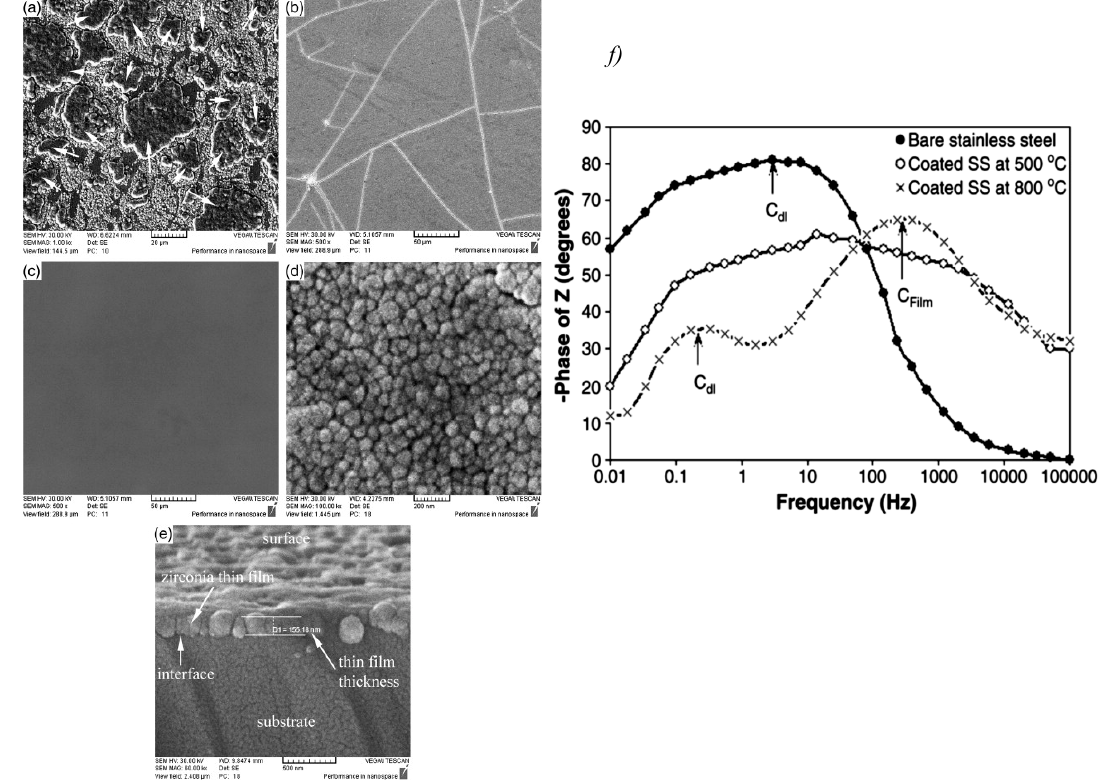
Figure 16. ( a – e ) SE ‐ SEM images of: ( a ) chromium oxide on the bare substrate; ( b ) cracked ZrO 2 thin film at 800 °C; ( c ) suitable nanostructure films at 500 °C ( d ) top view of thin film at 800 °C and ( e ) 7° tilted cross section of the film at 800 °C with a thickness of 155 nm on the substrate. ( f ) Bode diagram of bare stainless steel and ZrO 2 ‐ coated samples tested in 1 ‐ M H 2 SO 4 solution at 80 °C. Coated samples were heat treated at 500 and at 800 °C [109].